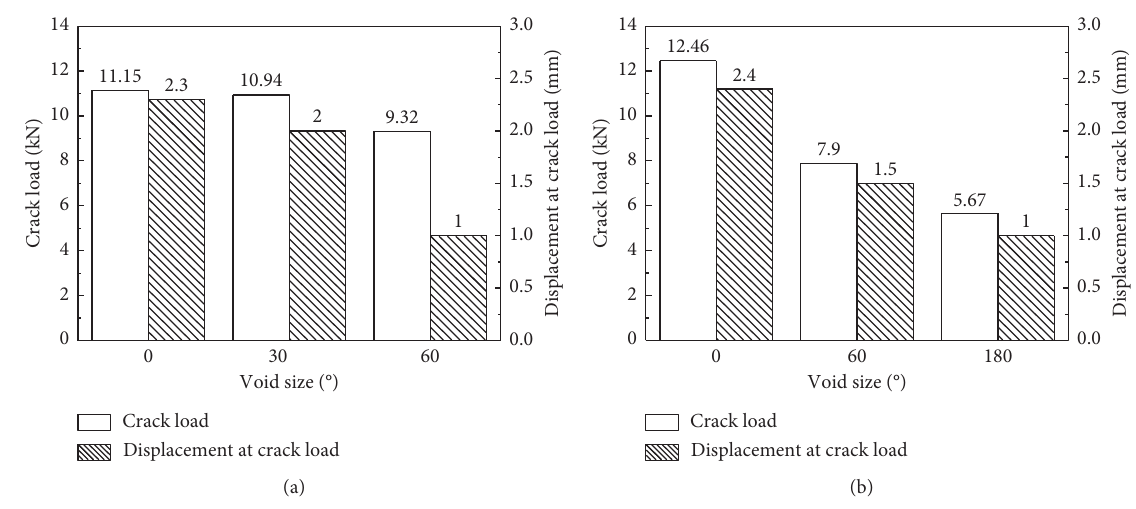
Figure 7: Crack load and the corresponding displacement of the lining with different void sizes: (a) crown and (b)